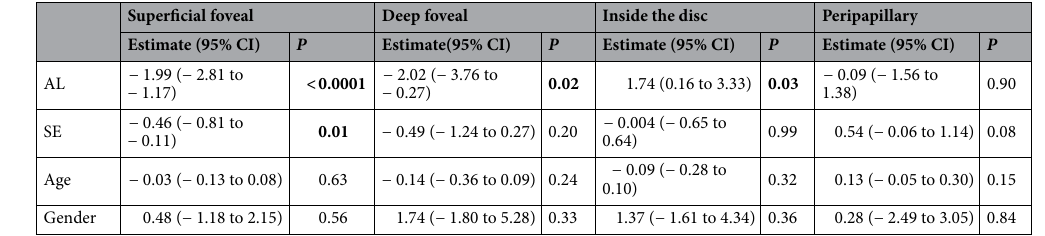
Table 4. Multiple regression analysis of associations with central foveal and the opic disc vascular density. AL: axial length; SE: spherical equivalent. Significant P values are in bold.